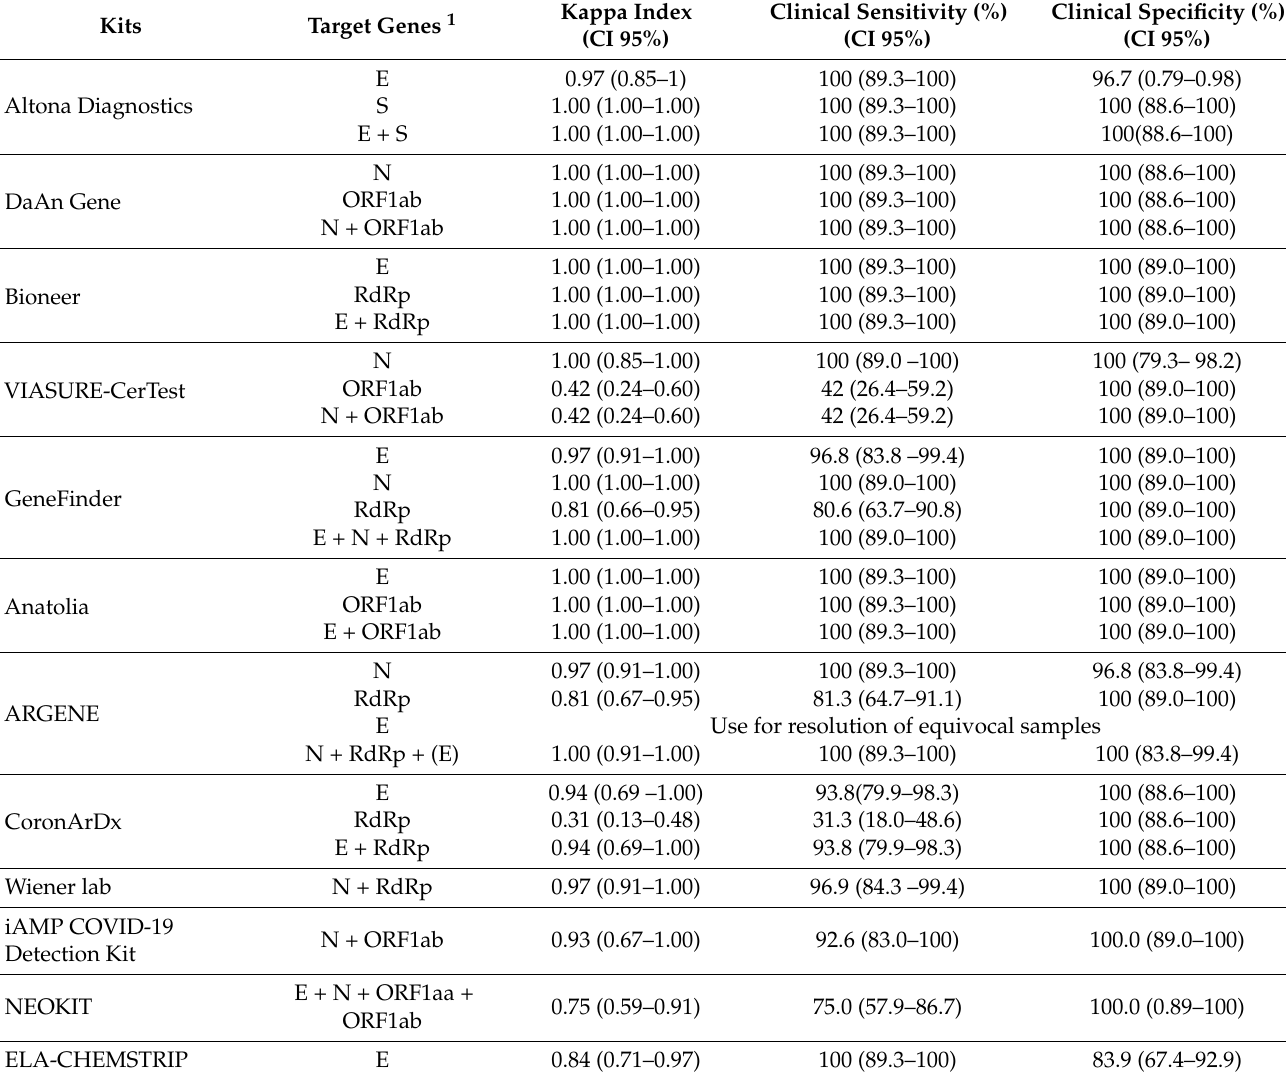
Table 2. Clinical performance of the different methodologies used for the detection of SARS-CoV-2 in Argentina.